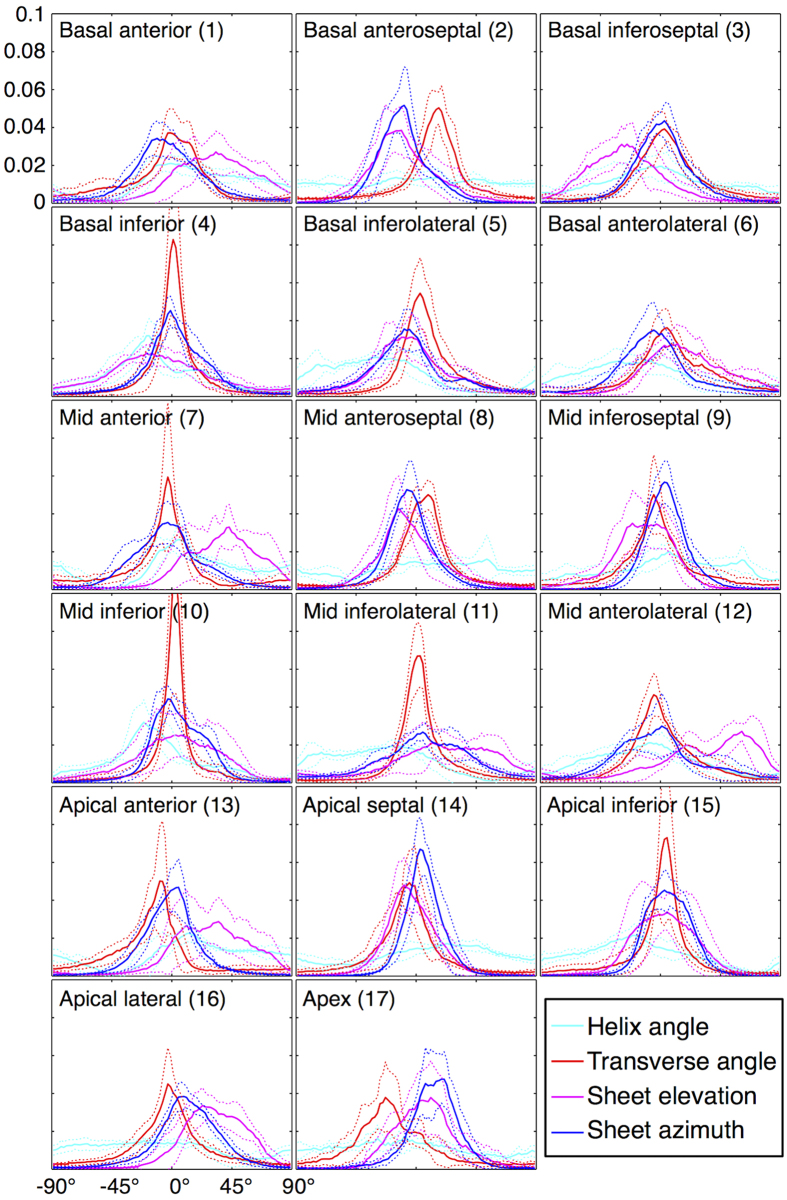
Histograms of the helix angle, transverse angle, sheet elevation and sheet azimuth.Regions were defined by the 17-segment AHA model. Means (solid lines) and standard deviations (dotted lines) over the five hearts are given.